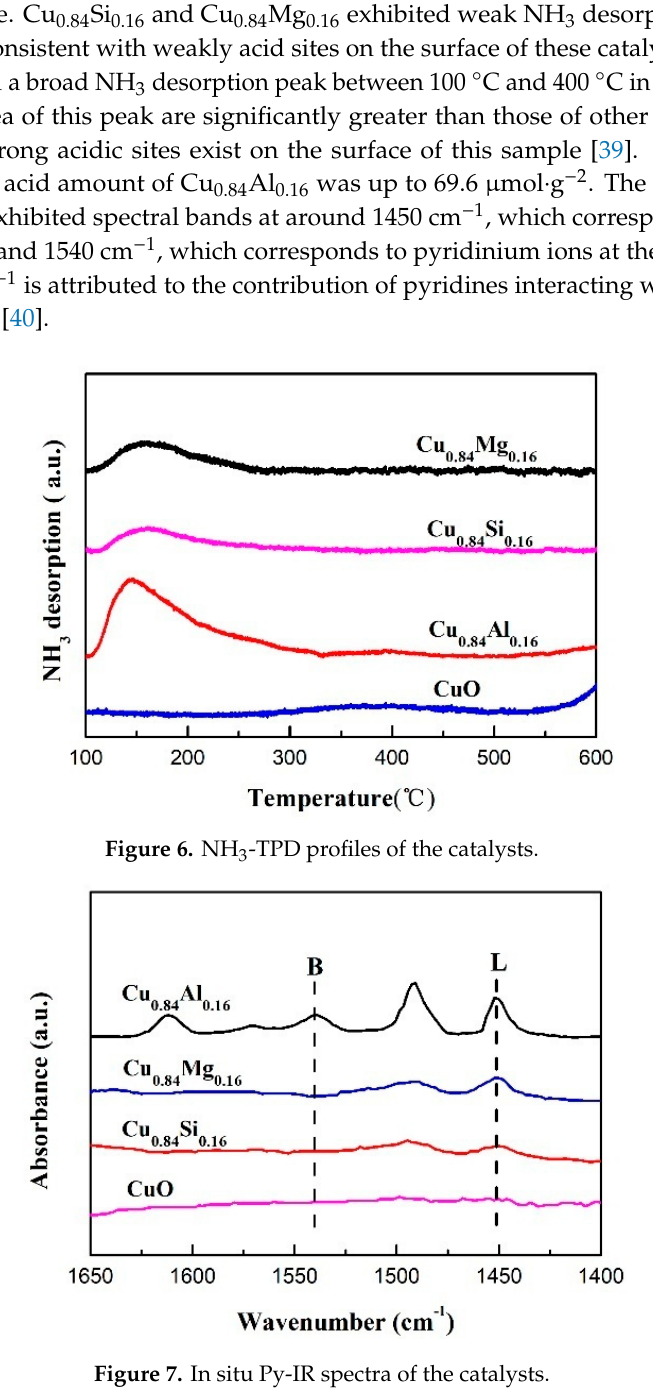
Figure 7. In situ Py-IR spectra of the catalysts.